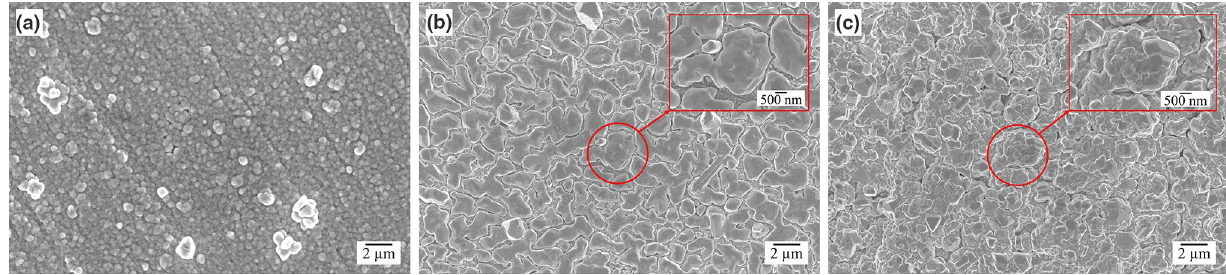
Fig. 1 Surface morphology of pulse electrodeposited ( a ) Cu layer, ( b ) Cu/In stack and ( c ) selenized CIS absorber. Insets show the high magnifi- cation images of corresponding red circular area in ( b ) and ( c